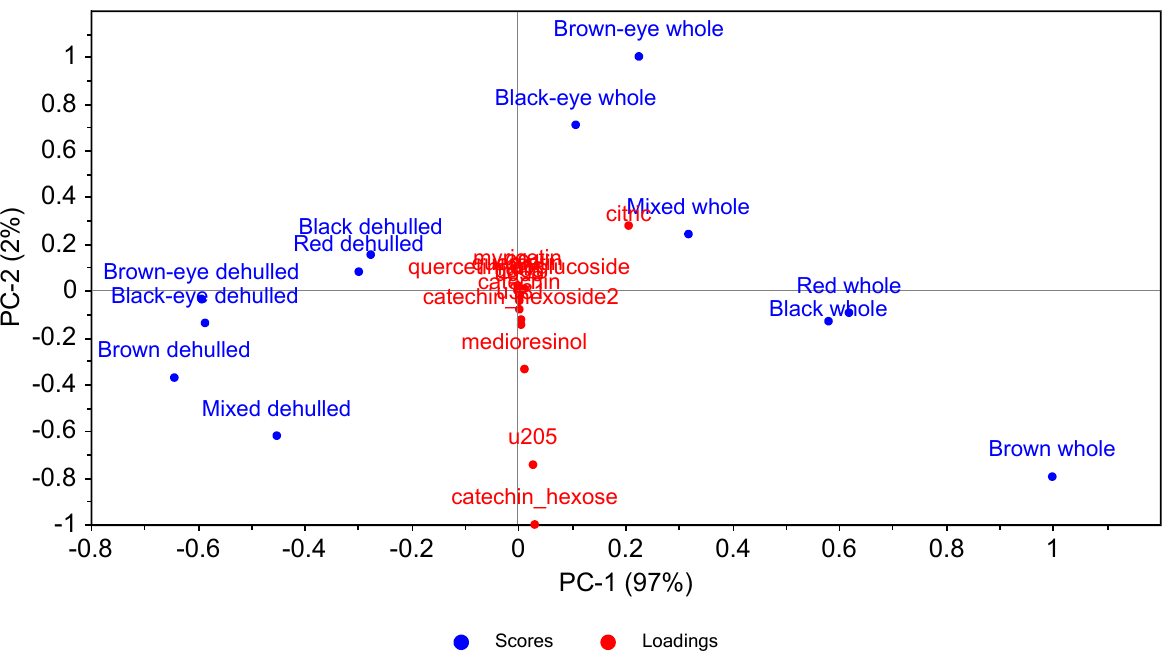
Figure 1 details the relationship between the BGN landraces and their flavonoid content. The first component explains 97% of the variation and the second component 2%. Similarly, two principal components explain the variation in phenolic acid of BGN landraces in Figure 2. The first component explains 70% of the variation and the second 22%.